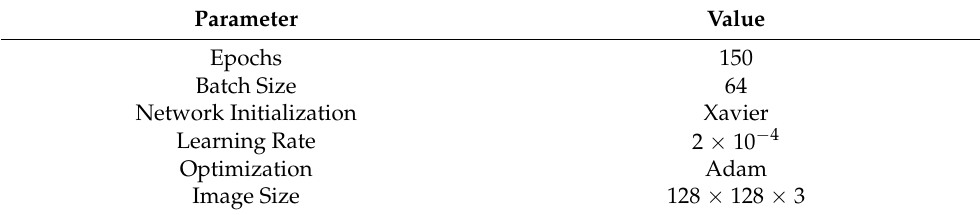
Table 2. The parameters used in this paper.